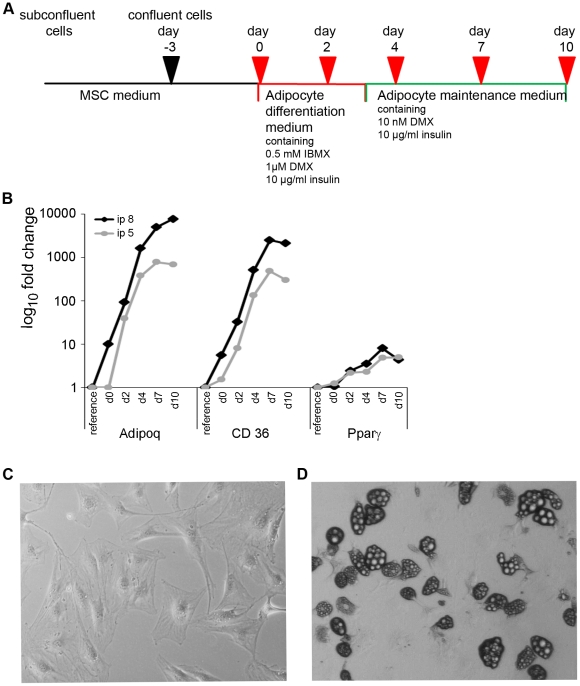
Differentiation of mesenchymal stem cells to adipocytes.
A: Protocol for the differentiation of mesenchymal stem cells to adipocytes. B: Real-time PCR-based expression analysis of the adipocyte marker genes adiponectin (Adipoq), CD36 and PPARγ during adipogenesis of murine mesenchymal stem cells. For verification two cell passages (ip 5 and ip 8) were independently differentiated and analyzed. Data were normalized by GAPDH expression and plotted as fold change (log10 scale) relative to the expression levels of the undifferentiated subconfluent reference cells. C, D: Phenotypical change from fibroblast-like murine mesenchymal stem cells (C, 100× magnification) to round-shaped adipocytes (D, 40× magnification).